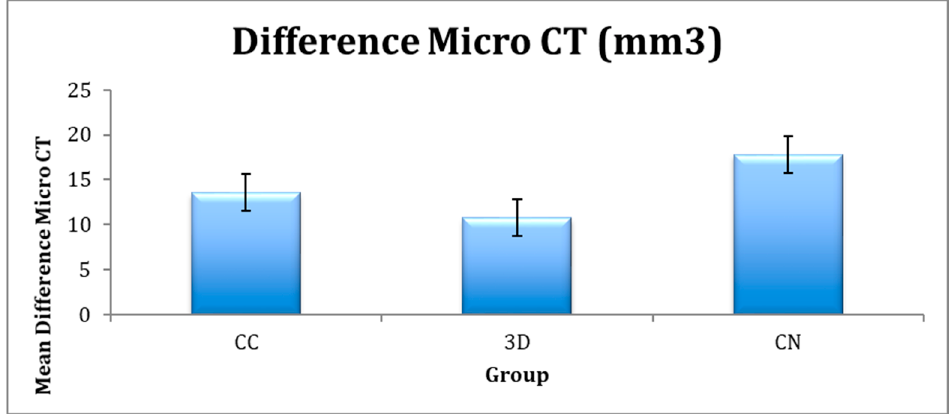
Figure 7. Mean difference of surface loss among the study groups using the micro CT technique.